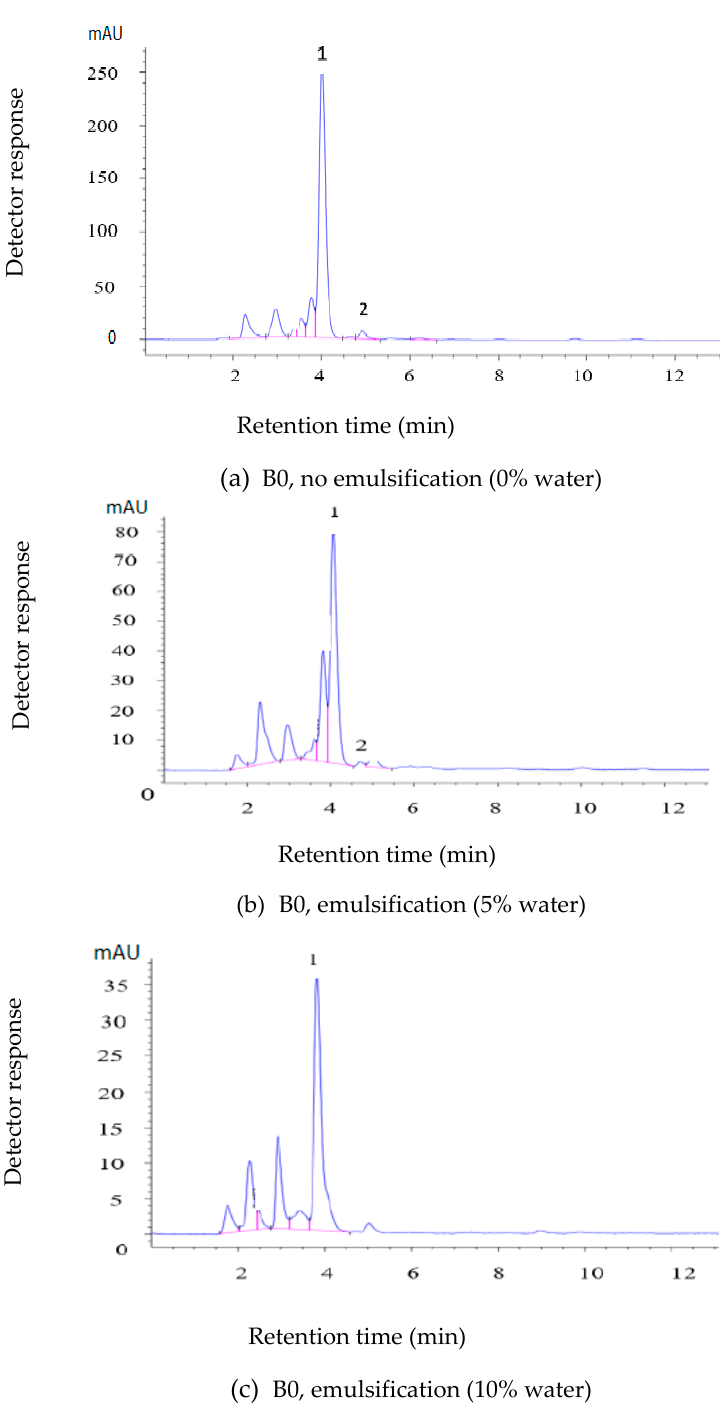
Figure 8. Liquid chromatogram of B0, ( a ) no emulsion, ( b ) 5% water, ( c ) 10% water. Table 6. Area under the Peaks and Their Corresponding Concentrations for Different Fuels.